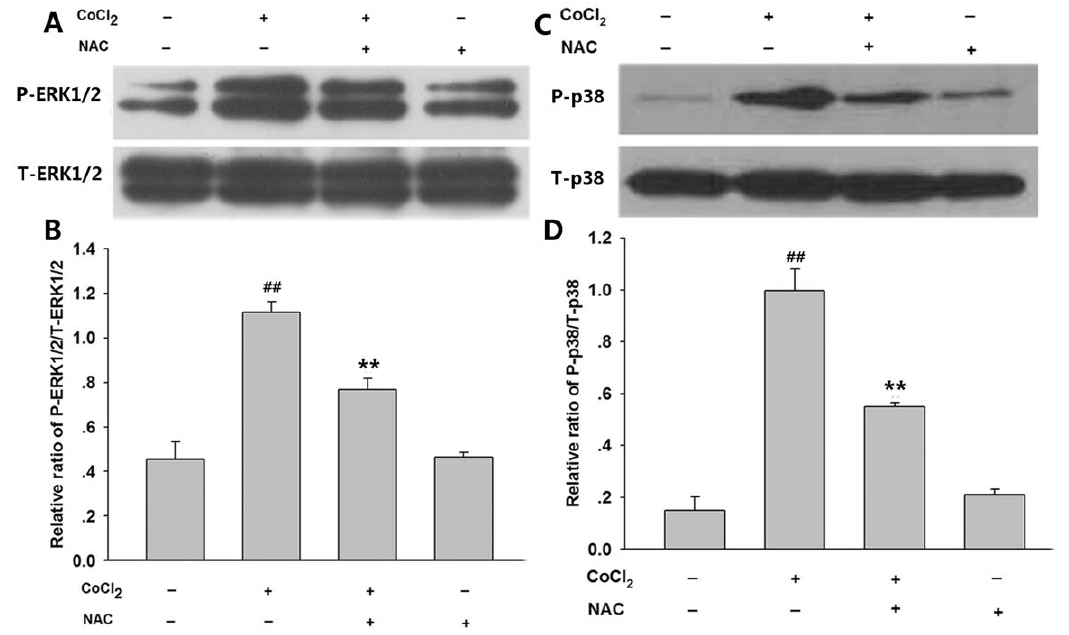
Figure 5. NAC attenuated CoCl 2 -induced ERK1/2 and p38MAPK phosphorylation in PC12 cells. PC12 cells were pretreated with 500 m mol/L NAC for 60 min prior to exposure of cells to 600 m mol/L CoCl 2 for 30 min (A) and (B) or 120 min (C) and (D). Cell lysates were subjected to western blot analysis using anti-p-ERK1/2 and anti-ERK1/2 antibody (A) and (B) or anti-p-p38 and anti-p38 antibody (C) and (D). (B) and (D) show denstiometric analysis for the data from (A) or (C), respectively. Data are presented as mean 6 SE from independent experiments preformed in triplicate. ## P , 0.01 compared to the control group, ** P , 0.01 compared to the CoCl 2 group.